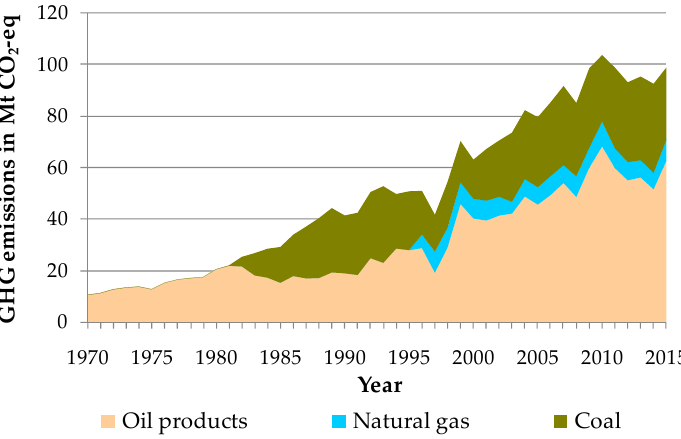
Figure 4. Greenhouse gas (GHG) emissions in Mt from fossil fuel consumption from 1970 to 2015 (yearly).